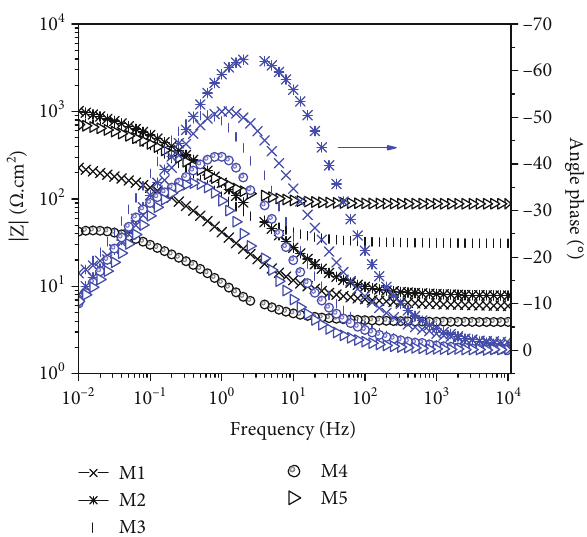
Figure 7: Modulus impedance and angle phase for aluminum- based alloy doped with Mn and Co after heat treatment at 1100 ° C immersed in 3 M